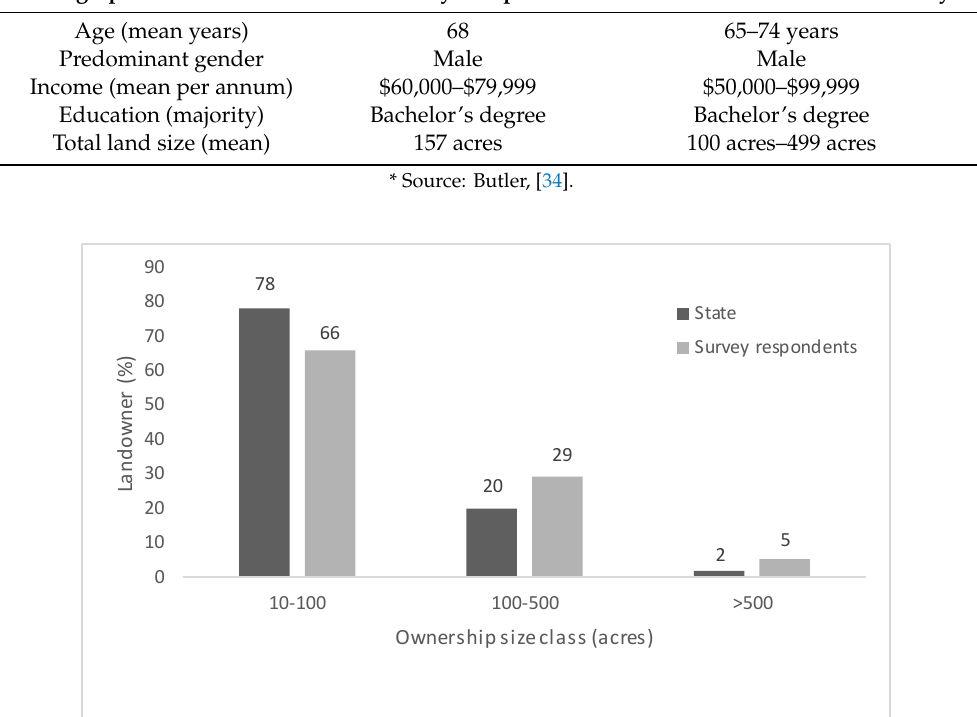
Figure 2. NIPF landowner distribution by ownership size class in Mississippi.